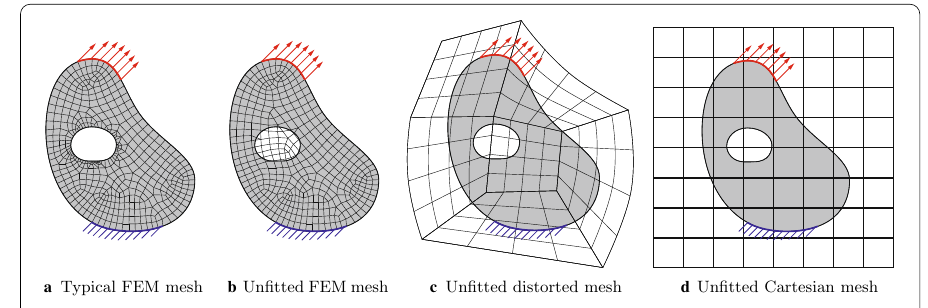
Fig. 1 Examples of typical discretizations in the framework of the FEM ( a ) and fictitious domain methods ( b – d ) based on unfitted